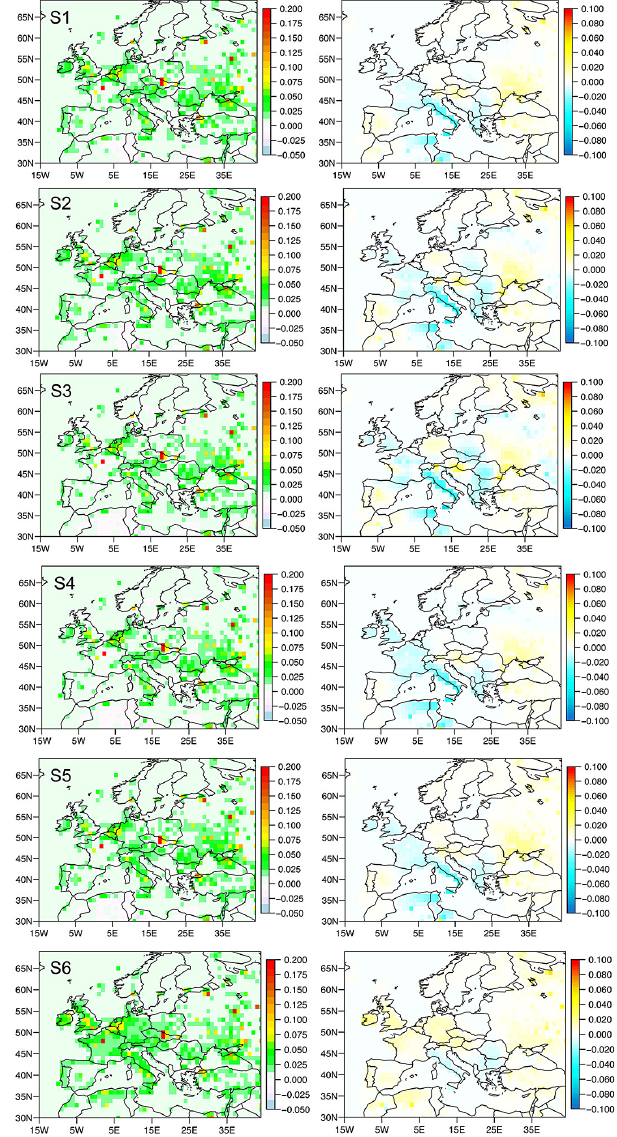
Figure 5. A posteriori fluxes of CH 4 (left) and the flux increments (i.e. a posteriori – a priori fluxes) (right) for each of the sensitivity tests (in units of gCH 4 m − 2 day − 1 )